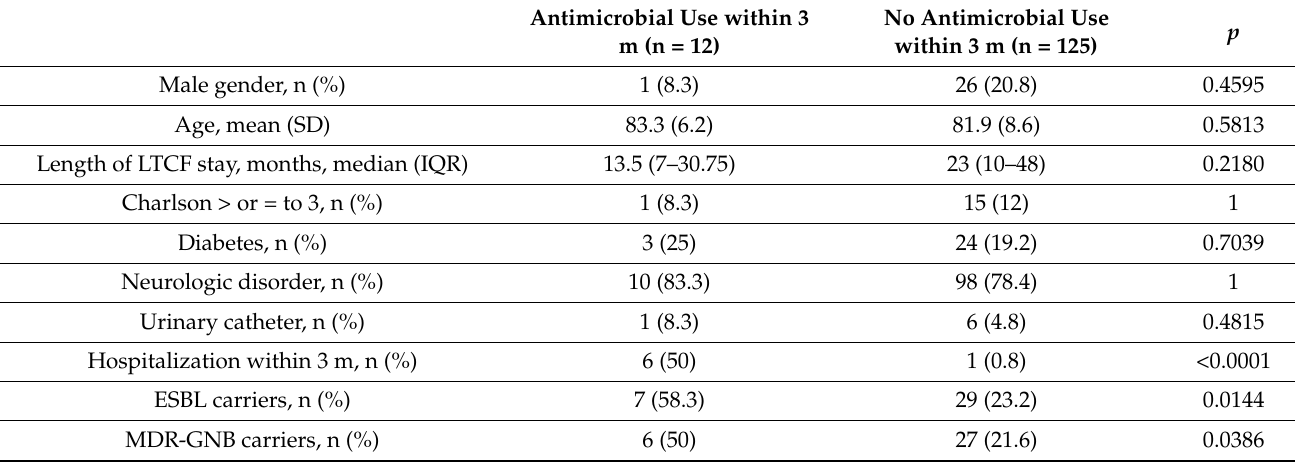
Table 3. Characteristics of LTCF residents regarding antimicrobial use within the last 3 months.